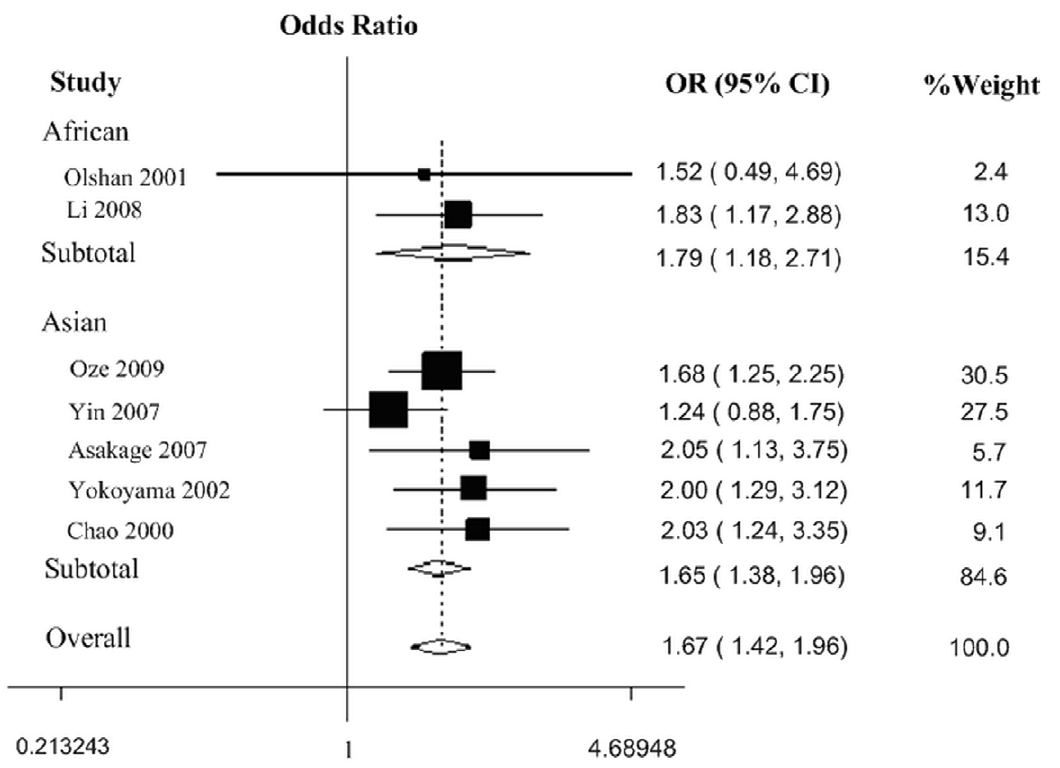
Figure 3. Forest plot of cancer risk associated with the ADH1C Ile350Val polymorphism in African and Asian populations (dominant model). The squares and horizontal lines correspond to the study-specific OR and 95% CI. The area of the squares reflects the weight (inverse of the variance). The diamond represents the summary OR and 95% CI.